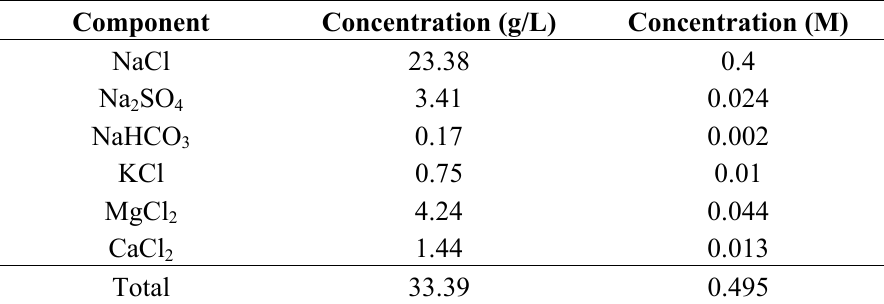
Table 1. Chemical composition of synthetic sea water